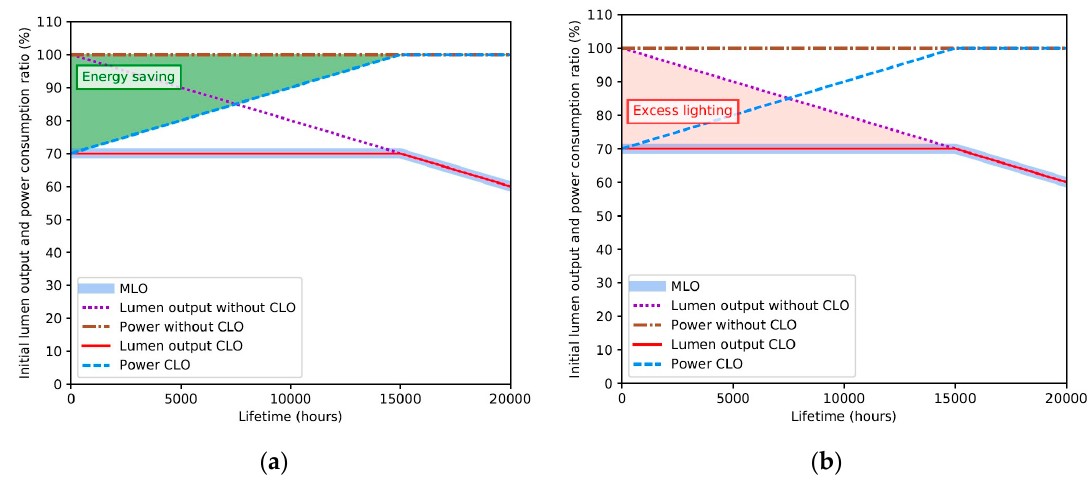
Figure 8. Lumen output and consumption for a L70 15,000 h lifetime light-emitting diode (LED) with and without constant lighting output (CLO). ( a ) Energy saving with CLO ( b ) Excess lighting without CLO.